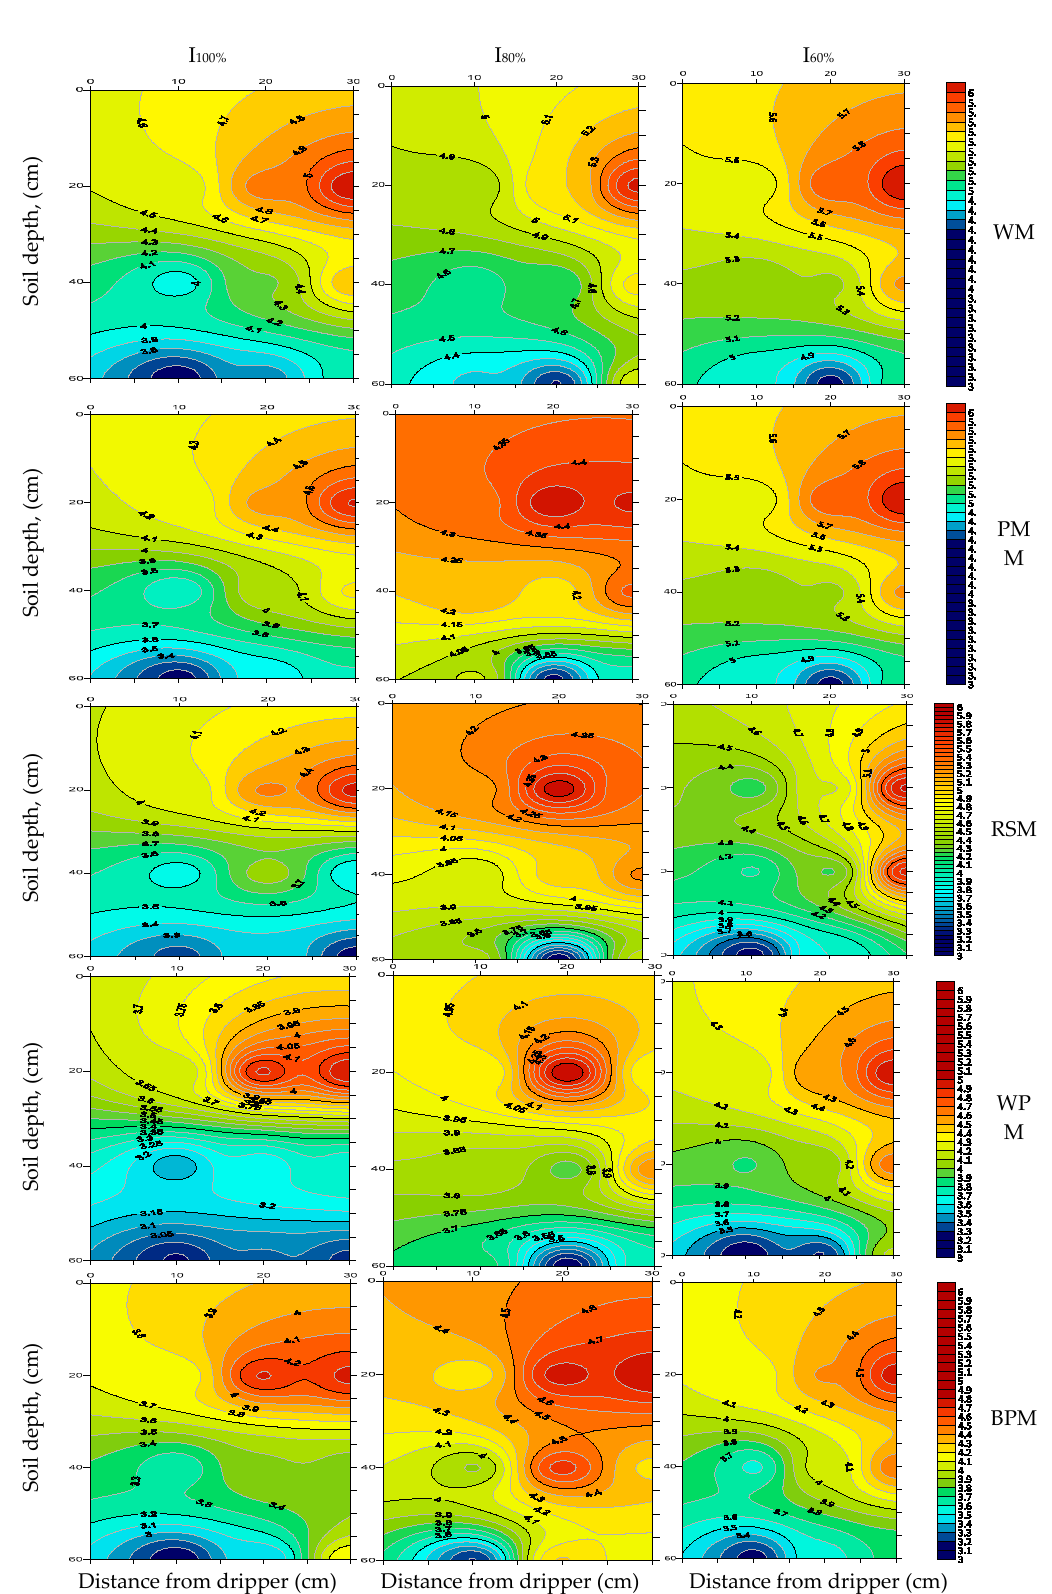
Figure 3. Distribution of ECe in the 0–60 cm soil depth and around the dripper under treatments. These findings are in confirmation with those of Abd El-Mageed et al. [47], who reported that all mulching materials effectively reduced salt accumulation in the root zone by reducing the flux of